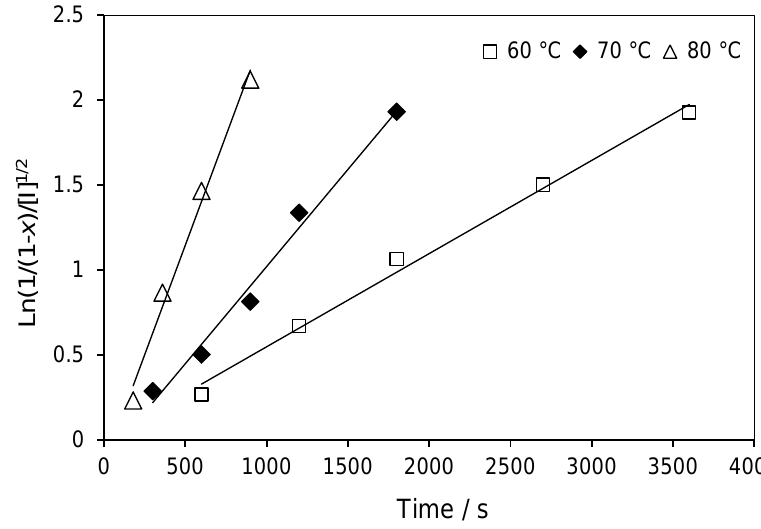
Figure 2. Plot of ln(1/(1 − x ))/[I] 1/2 versus time for free-radical polymerization of TBDMSMA at 60, 70, and 80 ◦ C in toluene. [TBDMSMA] = 1.5 mol · L − 1 , [AIBN] = 6.0 × 10 − 3 mol · L − 1 . Table 3. k t values for free-radical polymerization of TBDMSMA in toluene at different temperatures. Temperature ( ◦